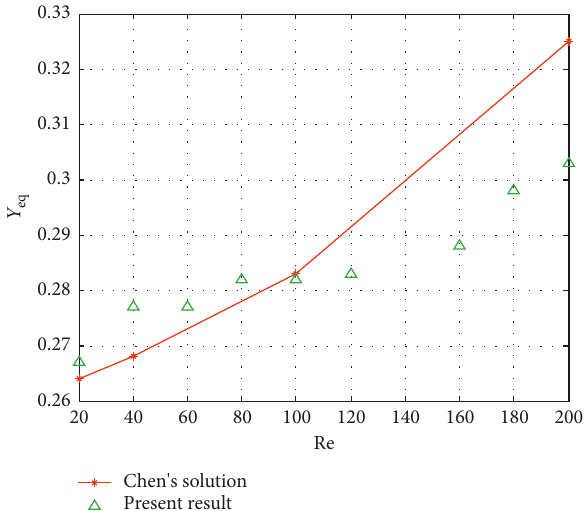
Figure 2: Comparison of the equilibrium position of a particle migrating in a straight channel.